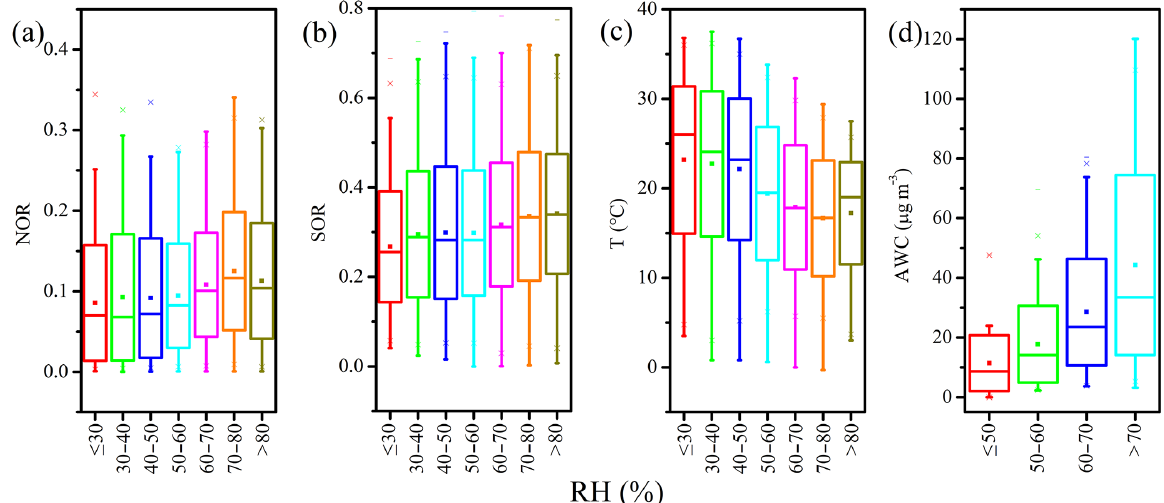
Figure 7. Effects of RH on the chemical conversion of NSA (nitrate, sulfate and ammonium). (a) NOR (nitrogen oxidation ratio). (b) SOR (sulfur oxidation ratio). (c) Temperature ( T ). (d) AWC (aerosol water content).